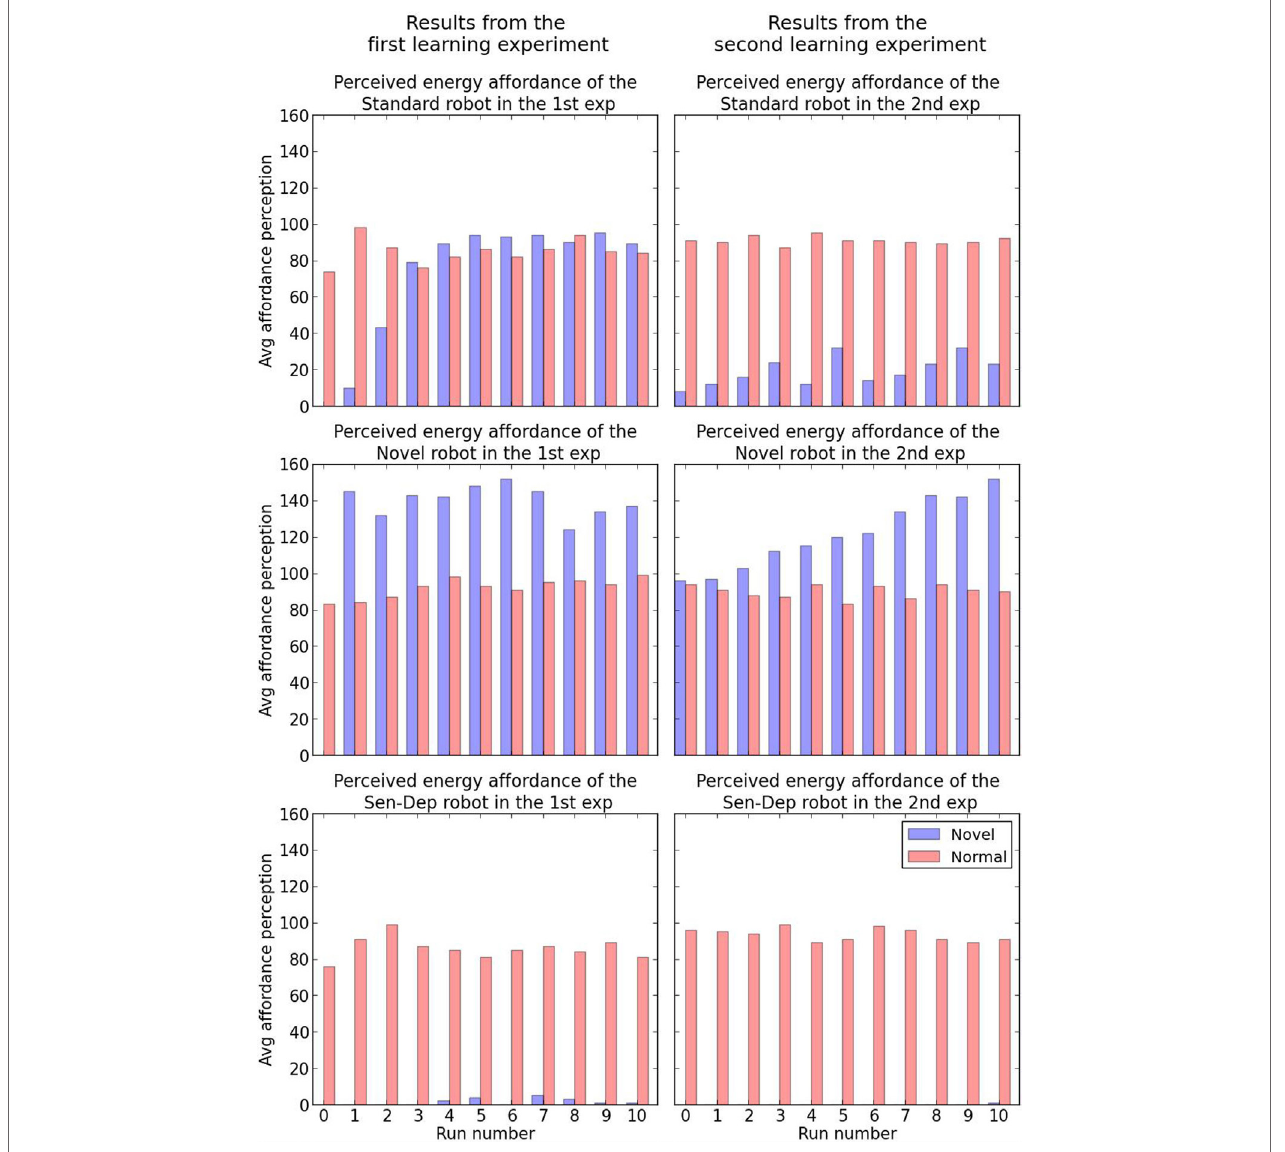
FigUre 11 | The results of the first (left) and second (right) part of the learning experiment . The units in the y-axis show the strength of the perceived energy affordance of the two objects which is determined by equation (12). Run 0 is the perceived energy affordance before the start of experiments.